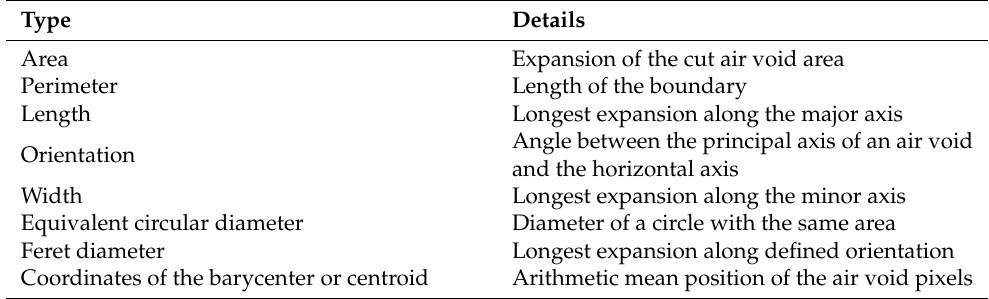
Table 2. Data types from the 2D evaluation.